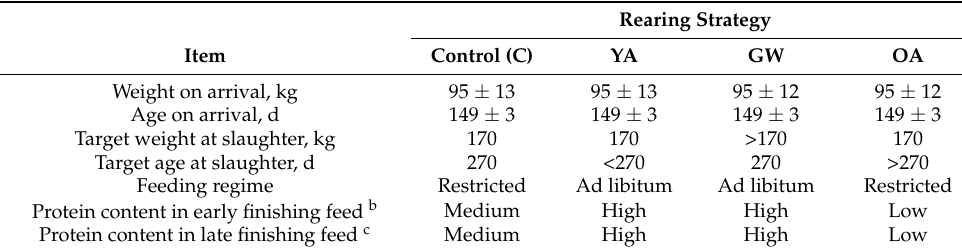
Table 1. Characteristics of the experimental groups raised according to the traditional (control, C), and three alternative rearing strategies (younger age, YA; greater weight, GW; and older age, OA) a .